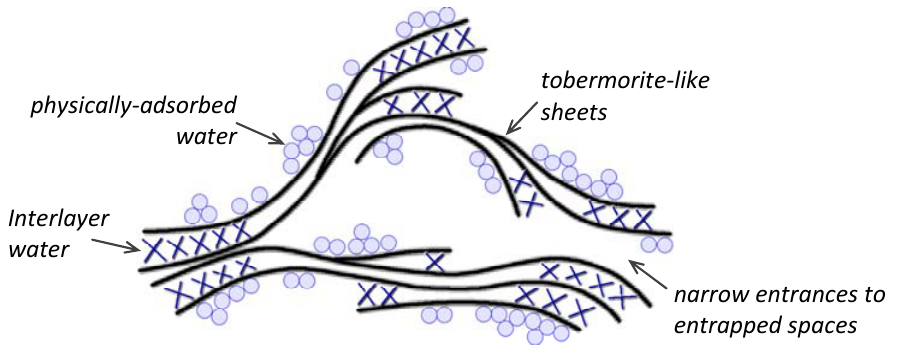
Figure 1. Simplified physical model for hydrated Portland cement.